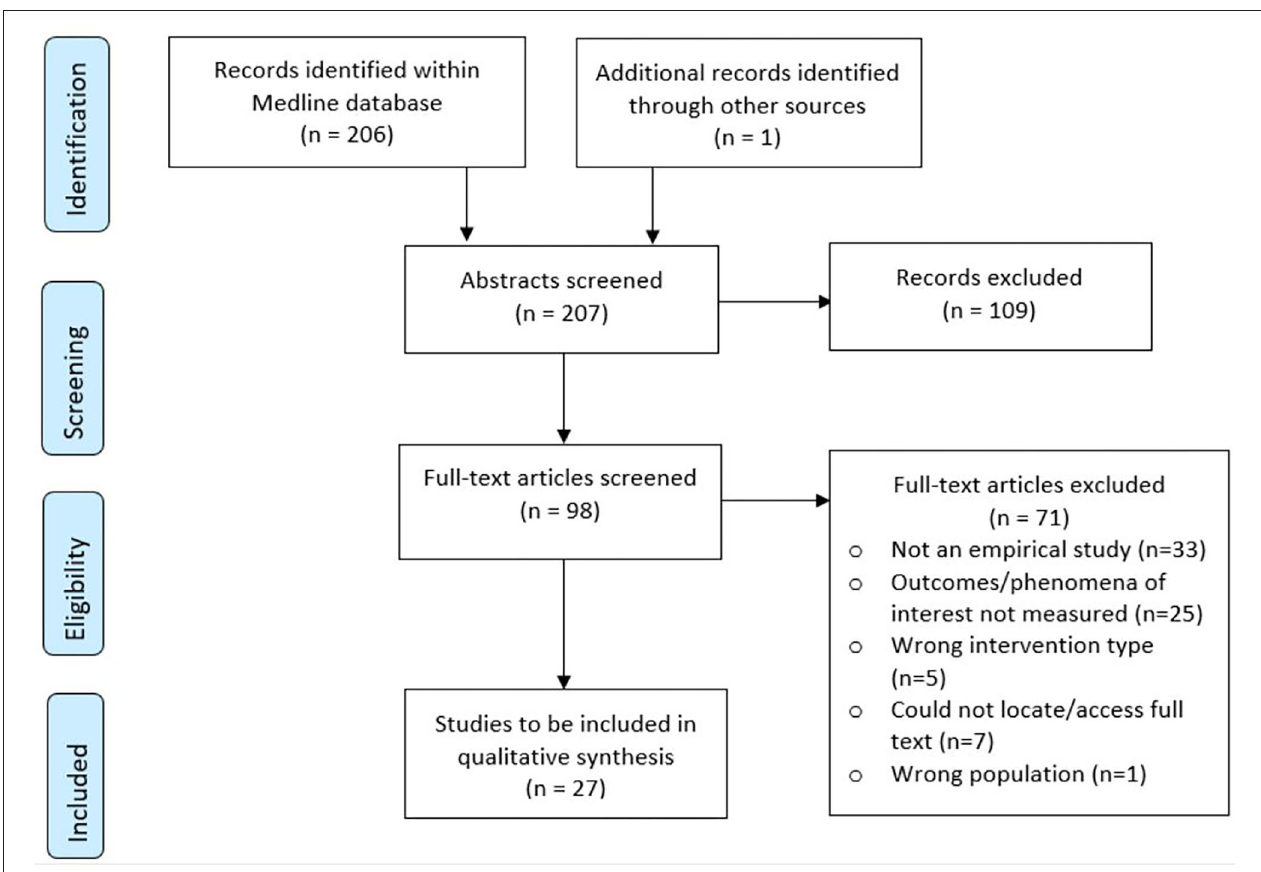
FIGURE 2 | PRISMA flow